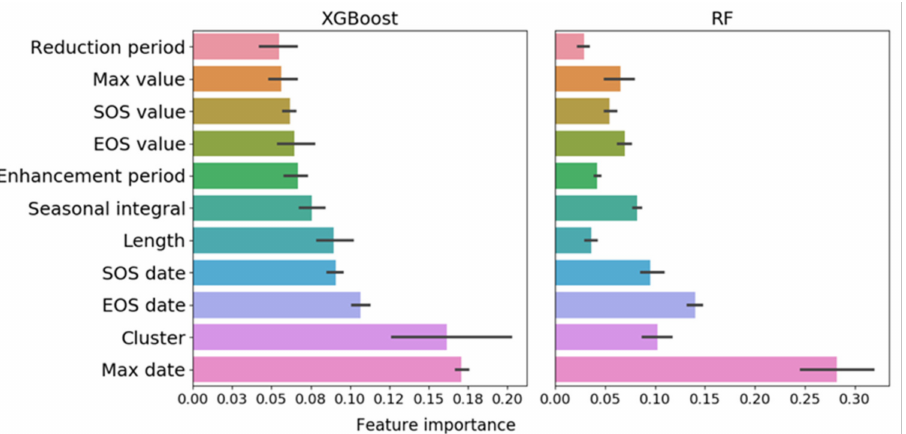
Figure 10. Feature importance for XGBoost and RF classifiers. The error bars represent the confidence interval for the four VIs (NDVI, OSAVI, NDRE, and